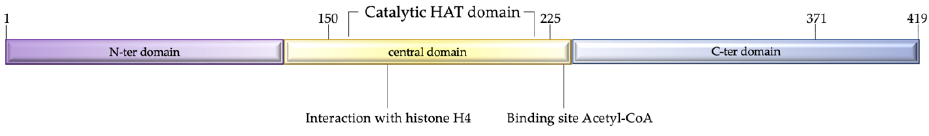
Figure 1. Graphical illustration of HAT1 function. ( A ) Interaction of the Hat1/Rbap46 complex with histones in the cytoplasm and subsequent transfer into the nucleus via importin, binding histone chaperone protein. ( B ) Once inside the nucleus, HAT1 interacts with CAF1 and facilitates the pathway for deposition of newly synthesized histones to regulate gene transcription.